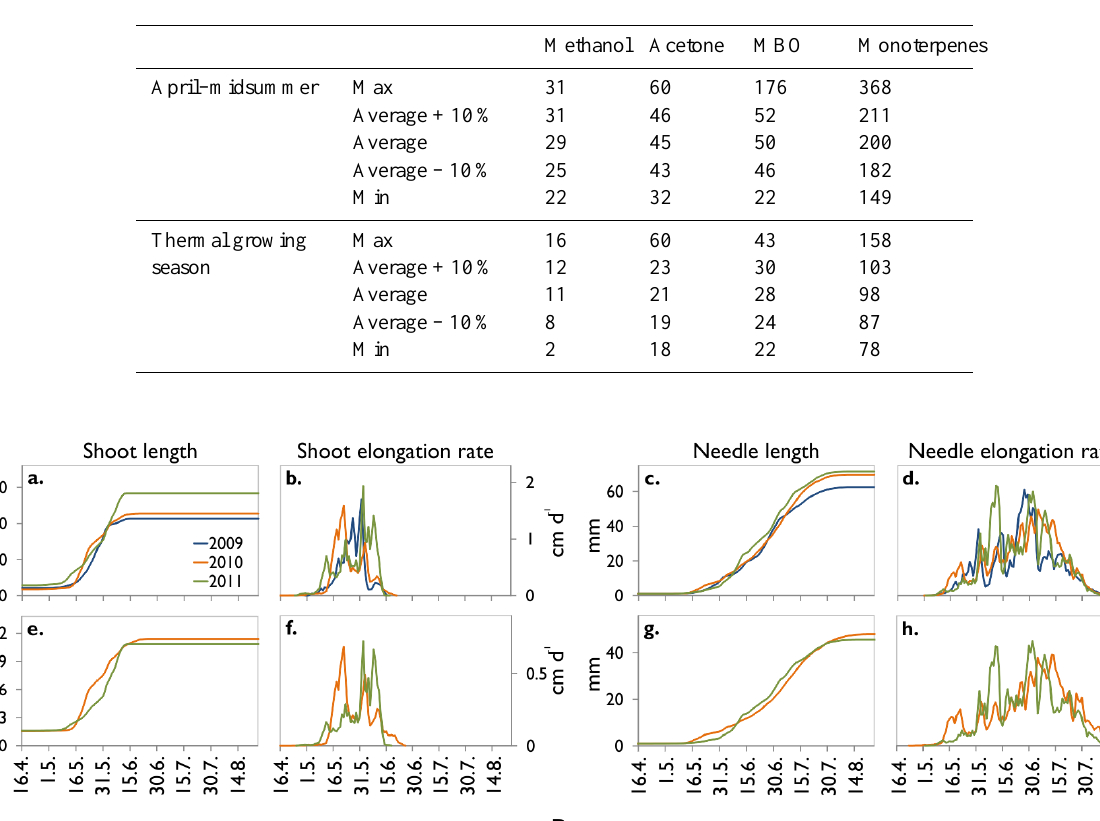
Table 2. The proportion (%) of the concealed emissions from canopy if the effect of growing Scots pine needle biomass on VOC emissions is not taken into account. 0% indicates no effect of the growing biomass on emissions; 100% indicates an equal emission from growing and mature needles; and > 100% a greater effect of growing biomass than the mature foliage on total canopy emissions. Average + 10% and average − 10% represent modified calculations where the proportion of growing needles has been increased or decreased by 10%, respectively. The periods represent the first half of and the whole thermal growing season (daily mean temperature permanently > 5 ◦ C).